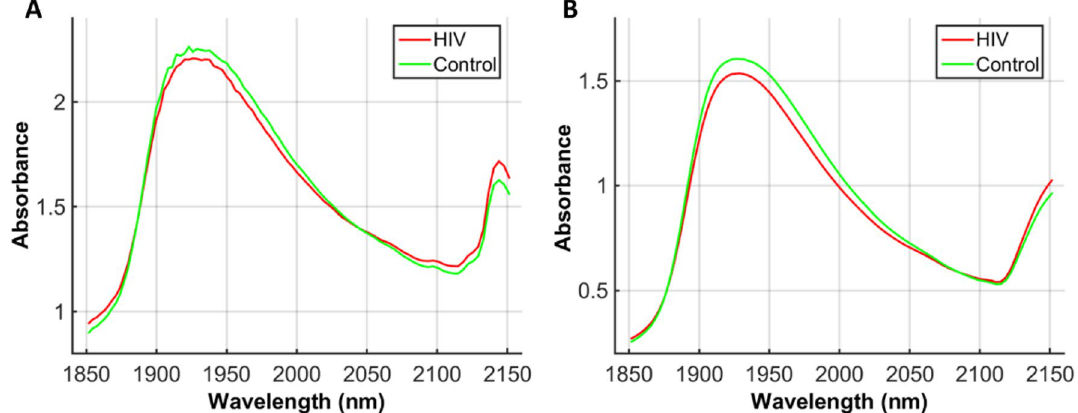
Figure 1. Average NIR spectra. ( A ) Raw spectra; ( B ) pre-processed (SG smoothing and baseline correction) spectra for the HIV-infected pregnant group (HIV) and healthy pregnant controls (Control).